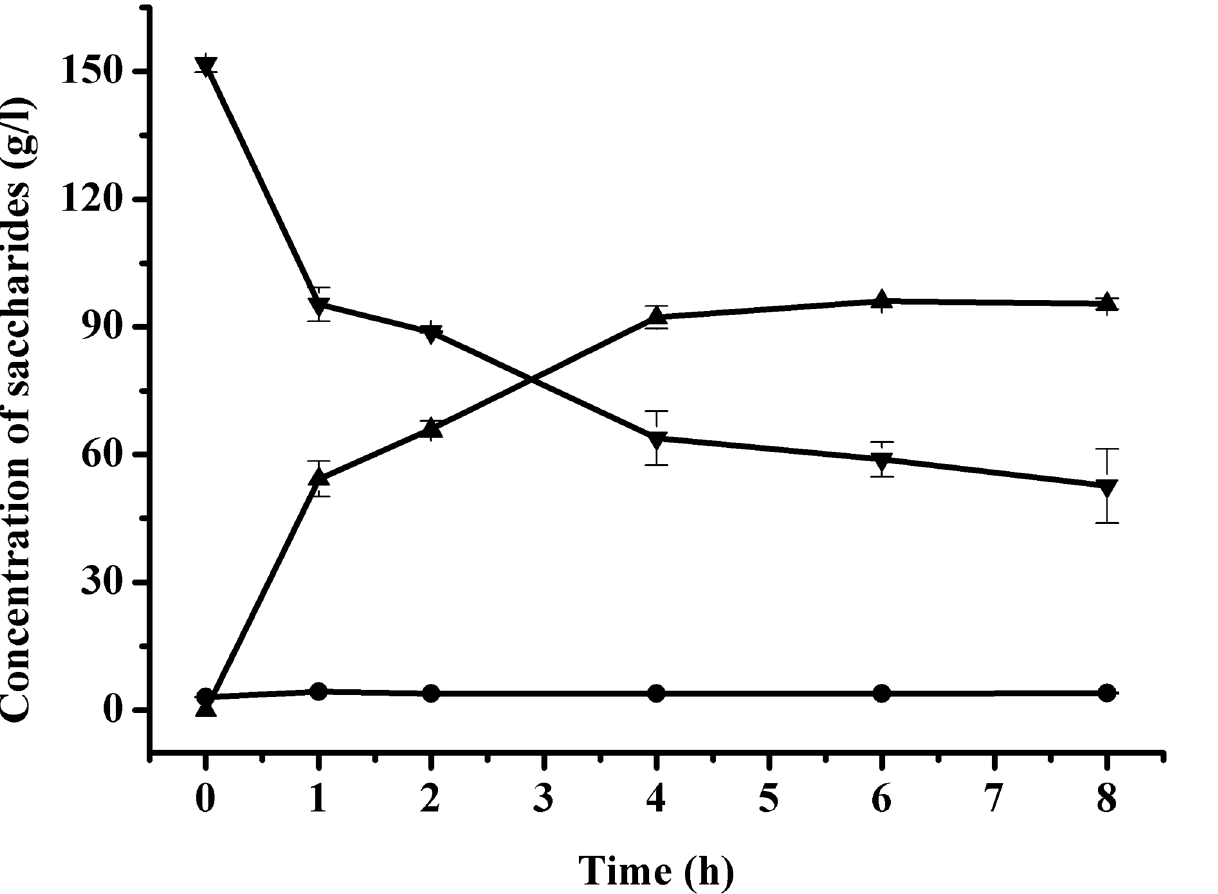
Fig 4. Time course of trehalose production from maltose under optimal conditions. Symbols represent: ▼ , maltose; ▲ , trehalose; ● , glucose.